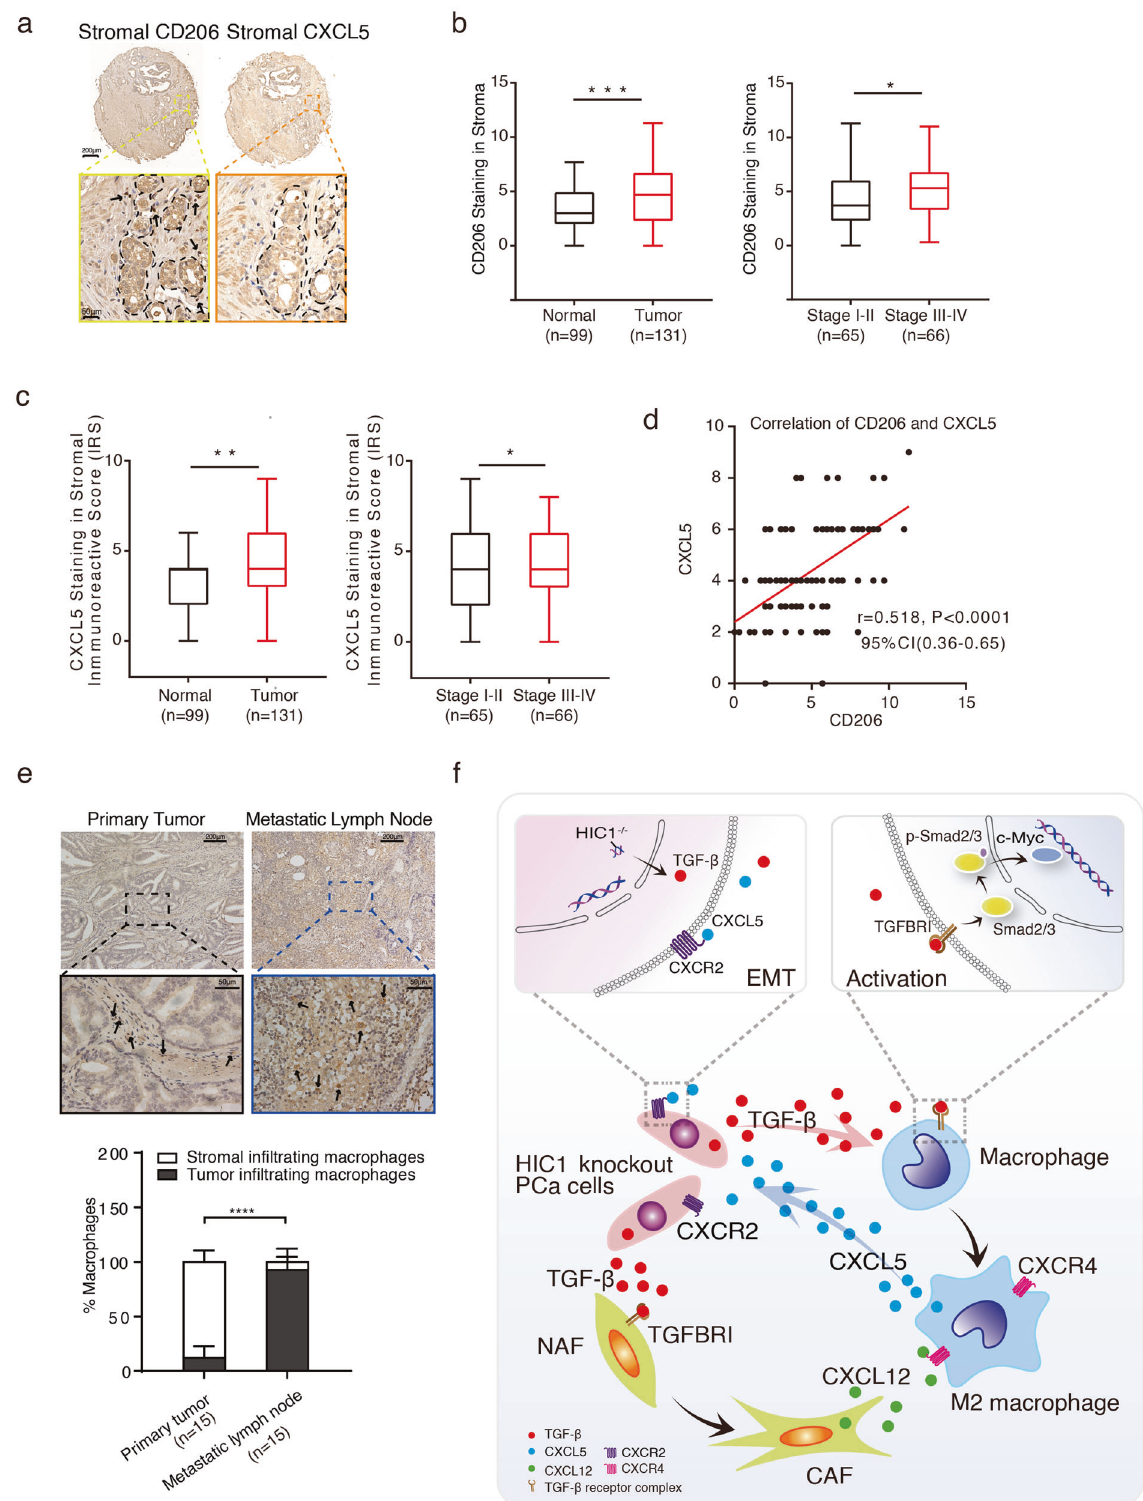
with localized PCa [66]. Here, we show that CXCL5 derived from M2 macrophages stimulates the AKT signaling pathway and contributes to the progression of PCa through EMT. Recently, strong evidence showed that high TGF- β secretion enhanced Th17 subsets in bone metastases of patients who were Cell Death and Disease (2022)